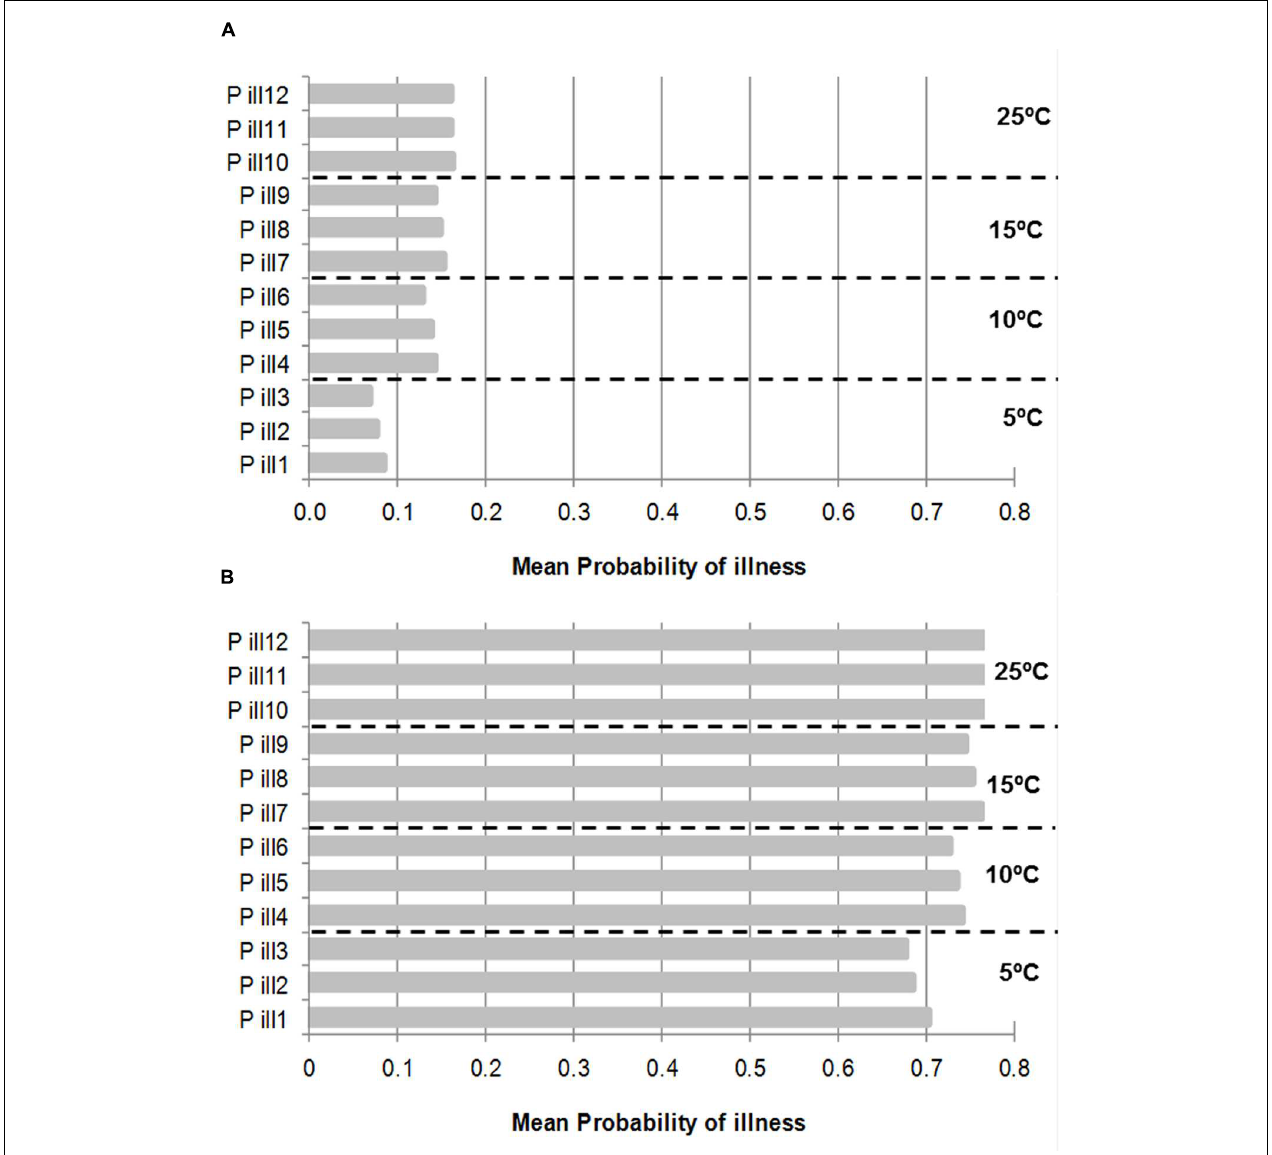
FIGURE 5 | Mean Probability of illness by consumption of PIF contaminated with an initial inoculum of 1 cell (A) and 50 (B) cells and growth at four different temperatures. Each temperature has three probability of illness according to cells treated with 50 ◦ C by 0 (P ill 1), 5 min (P ill 2), and 10 min (P ill 3) and so on, respectively. The concentration to estimate the probabilities were taken from stochastic growth model using the cut-off point when the deterministic growth model reached 1000 CFU/ml (See Figure 3